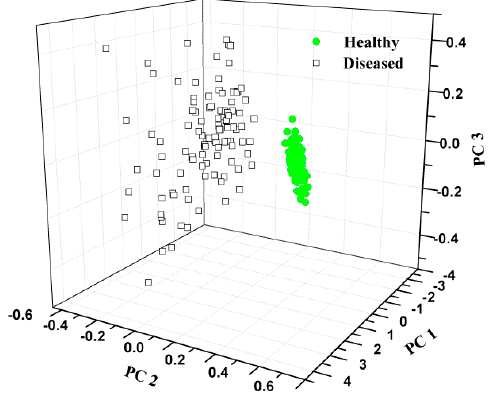
Figure 4. Samples distribution of PCA based on the spectrum.